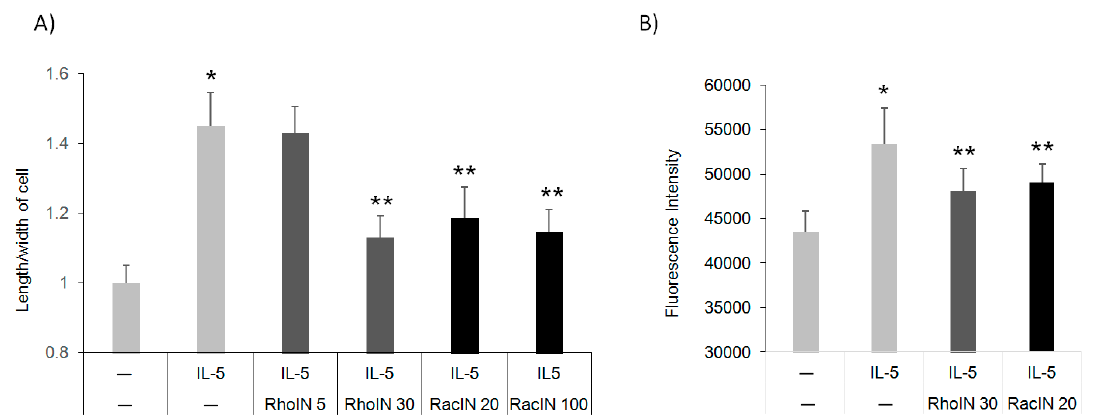
Figure 4. Rho inhibitors suppress IL-5-induced Eos polarization and migration. ( A ) Human peripheral blood Eos were starved and incubated with RhoA (5 and 30 µ M) or Rac2 inhibitor (20 and 100 µ M) for 2 h before treatment with IL-5 (5 ng/mL) and shape measurement. ( B ) Cells were treated with inhibitors as in ( A ) before the induction of cell migration toward hIL-5 (50 ng/mL). Data are from three independent experiments. * p < 0.05 between untreated (–) and IL-5, ** p < 0.05 between IL-5 and IL-5+GTPase inhibitors.